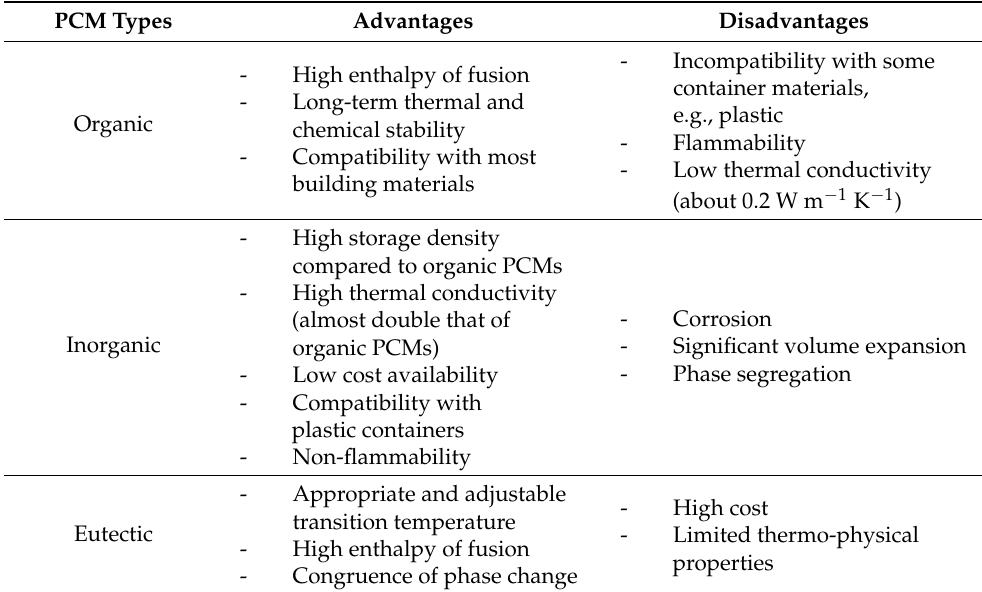
Table 2. Advantages and disadvantages of the different types of PCMs